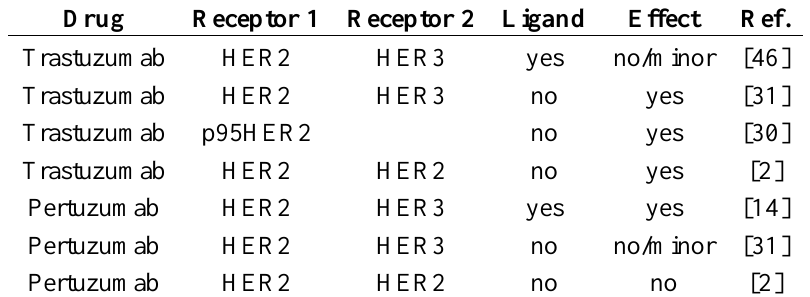
Table 1. Inhibition effects of trastuzumab and pertuzumab on homo- and heterodimerisation of HER3 and HER2 receptors in the presence/absence of HER3